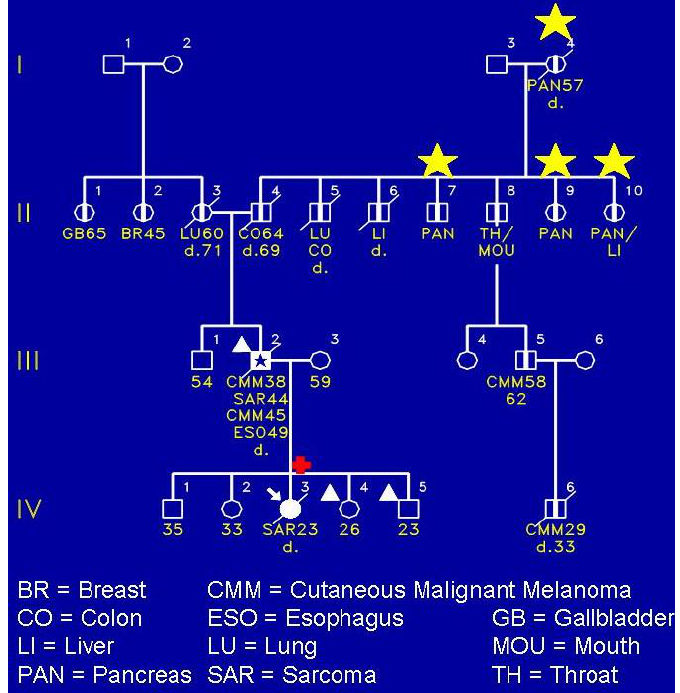
Figure 3. A FAMMM syndrome affected (III-2) patient with cutaneous